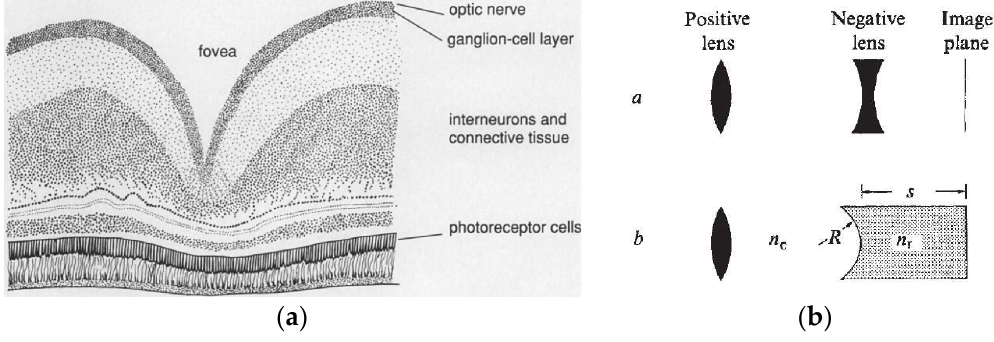
Figure 1. ( a ) Microscope image of a fovea wherein the deep “v”-shape acts as a negative element in the lens system [19]; ( b ) Model of a telephoto lens system and a modification to illustrate its similarity to the fovea wherein the negative lens is replaced by a spherical (concave) surface